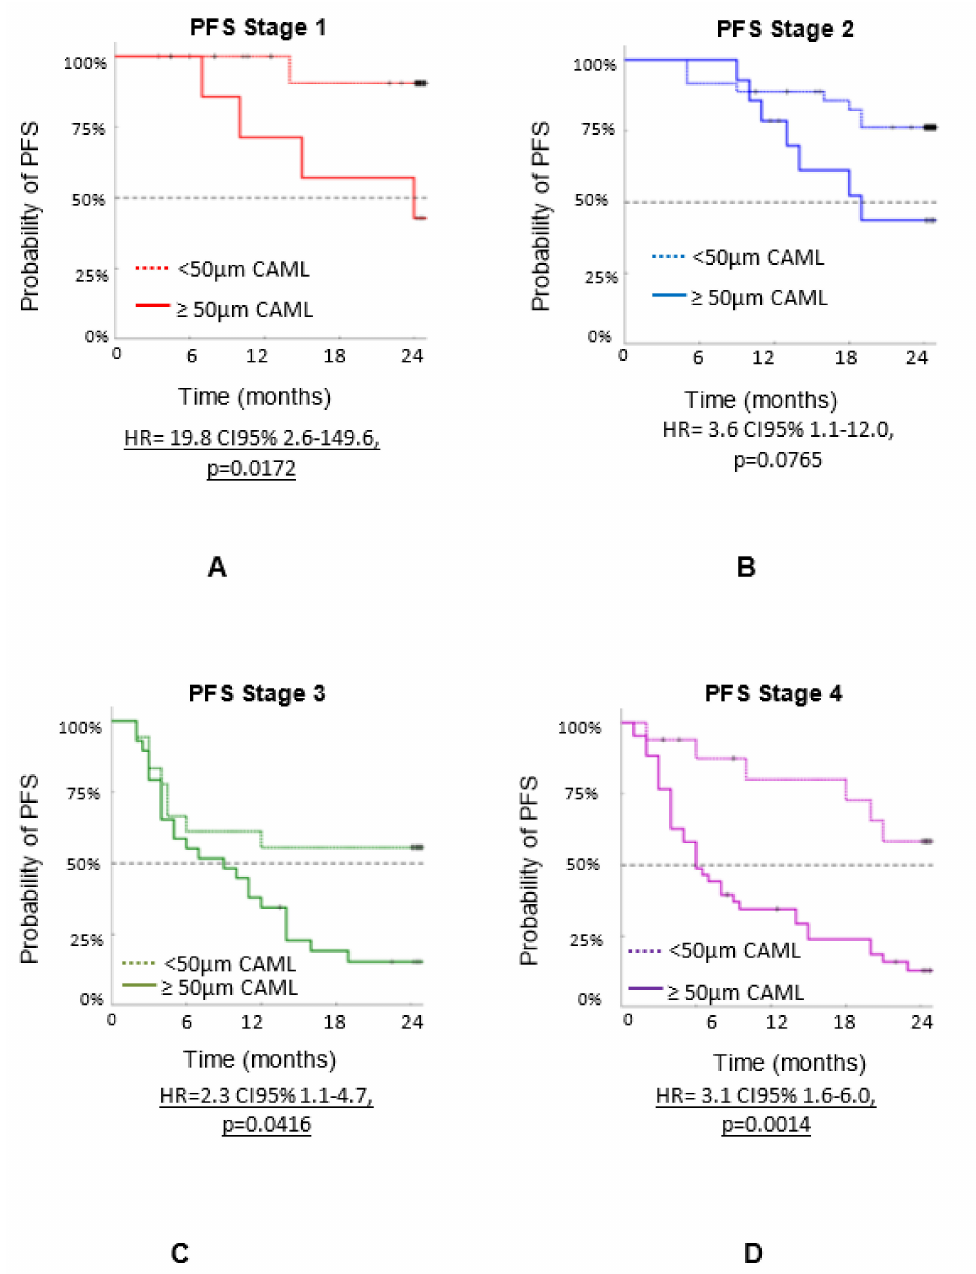
Figure 5. PFS of n = 192 patients with three types of cancers (breast, prostate, and lung) by stage. PFS based on CAML size at each stage of cancer, determined during a 24-month follow-up: ( A ) Stage 1, ( B ) Stage 2, ( C ) Stage 3 and ( D ) Stage